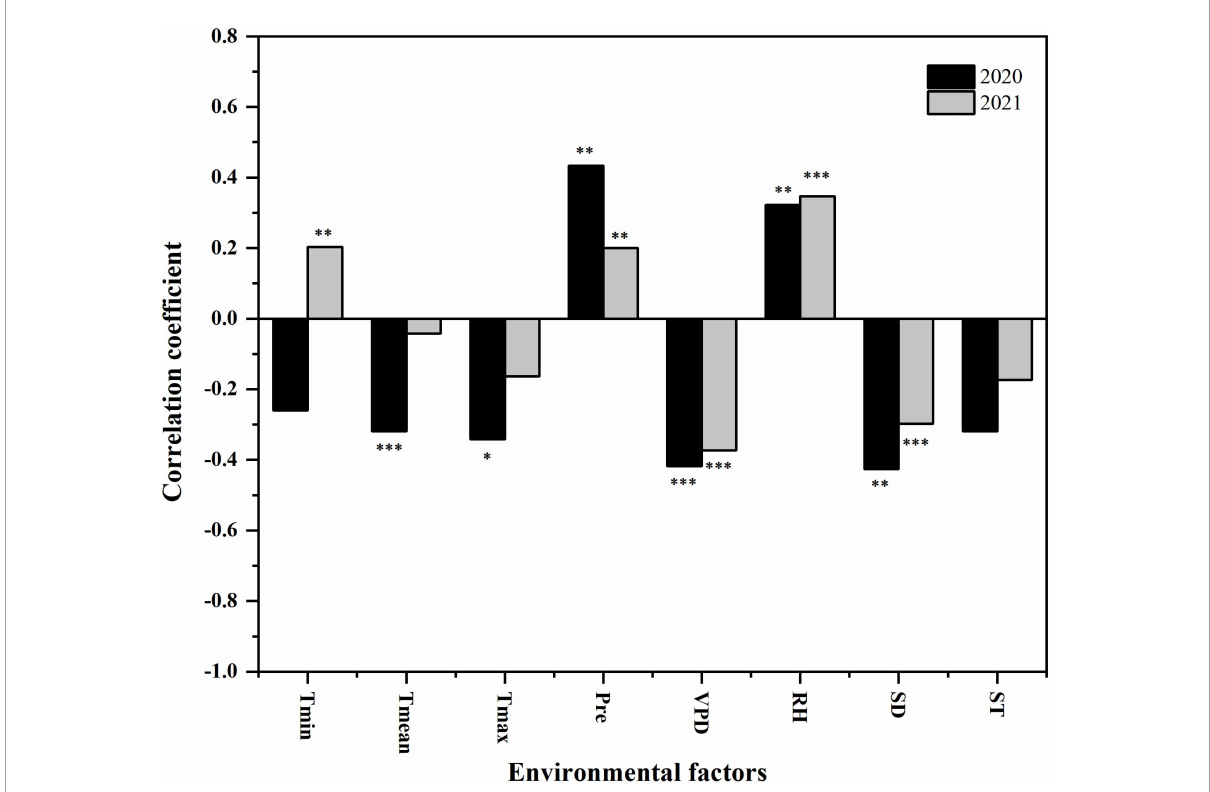
FIGURE6 Spearman correlations of SRI and air temperature (mean, Tmean; minimum, Tmin; and maximum, Tmax), precipitation (Pre), relative humidity (RH), vapor pressure deficit (VPD), sunshine duration (SD), and soil temperature (ST) in 2020 and 2021. Significance levels (* p < 0.05; ** p < 0.01; *** p <